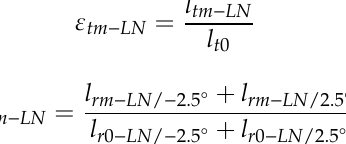
Figure 1. Description of parameters. ( a ) Position of the marking lines and curves on the blank disk. ( b ) Relationship among radial and circumferential directional lengths and angle between radial scratch lines.